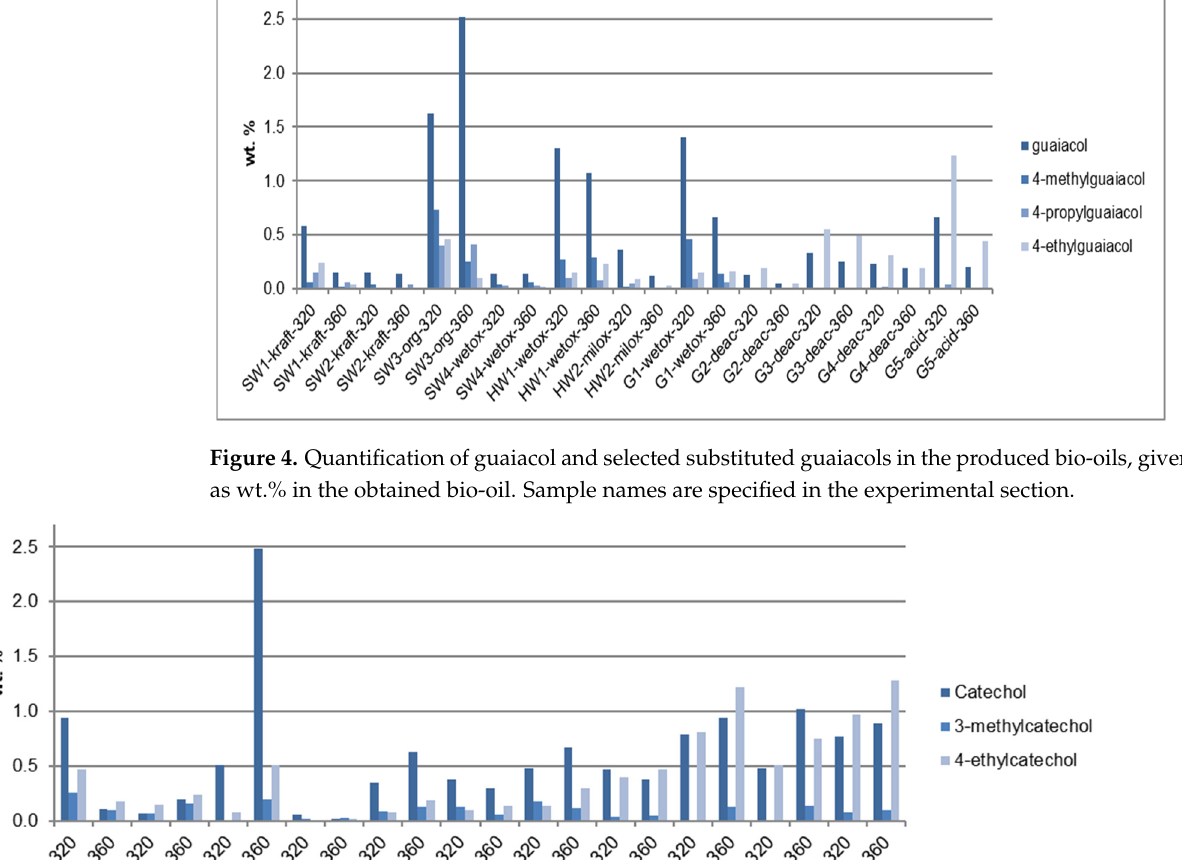
Figure 5. Quantification of catechol and selected substituted catechols in the produced bio-oils, given as wt.% in the obtained bio-oil.